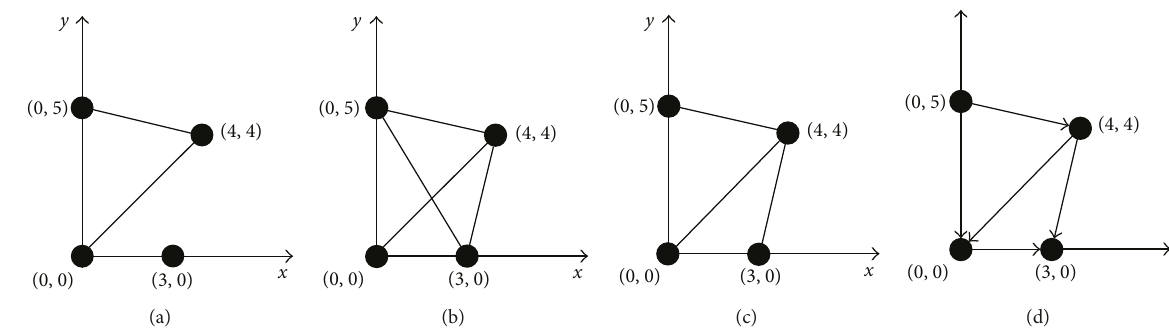
Figure 1: Examples of graphs in 2D space. (a) Flexible graph. (b) Rigid graph. (c) Min-weighted rigid graph. (d) Optimal persistence graph. The four agents in the plane are (0, 0), (3, 0), (4, 4), and (0,